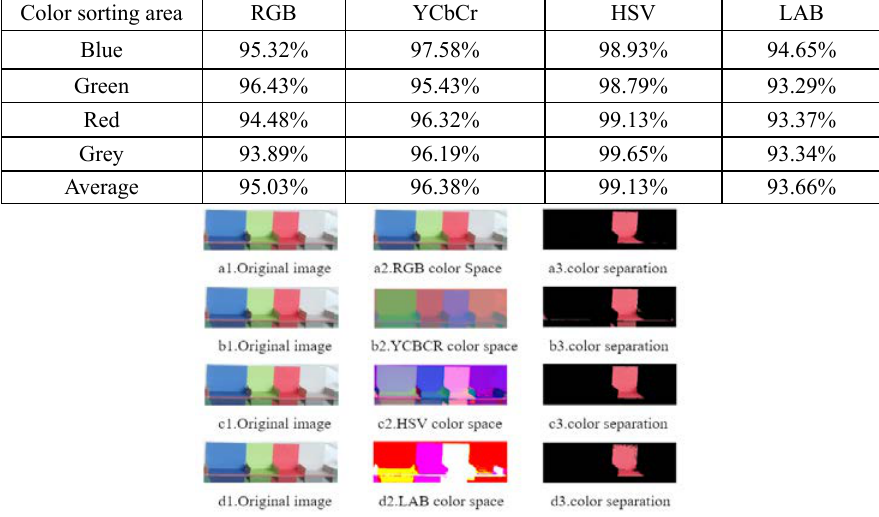
Fig. 8. Color separation renderings of different color